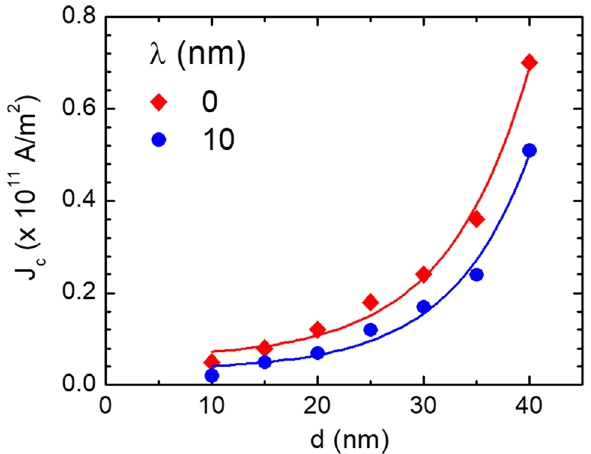
Figure 6. The critical or minimum current density for depinning a skyrmion versus the depth d of the stepped region.